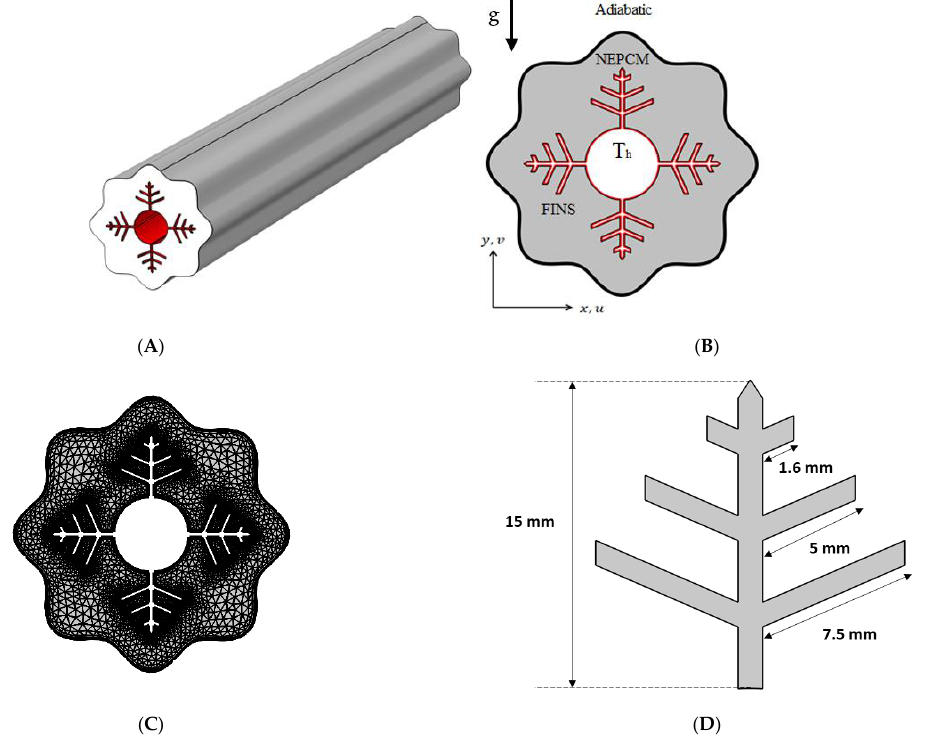
Figure 1. ( A ) Three-dimensional model of the shell and tube TEs with embedded fins; ( B ) A two- dimensional illustration of the studied model with boundary conditions; ( C ) A mesh sample; ( D ) fins dimensions.